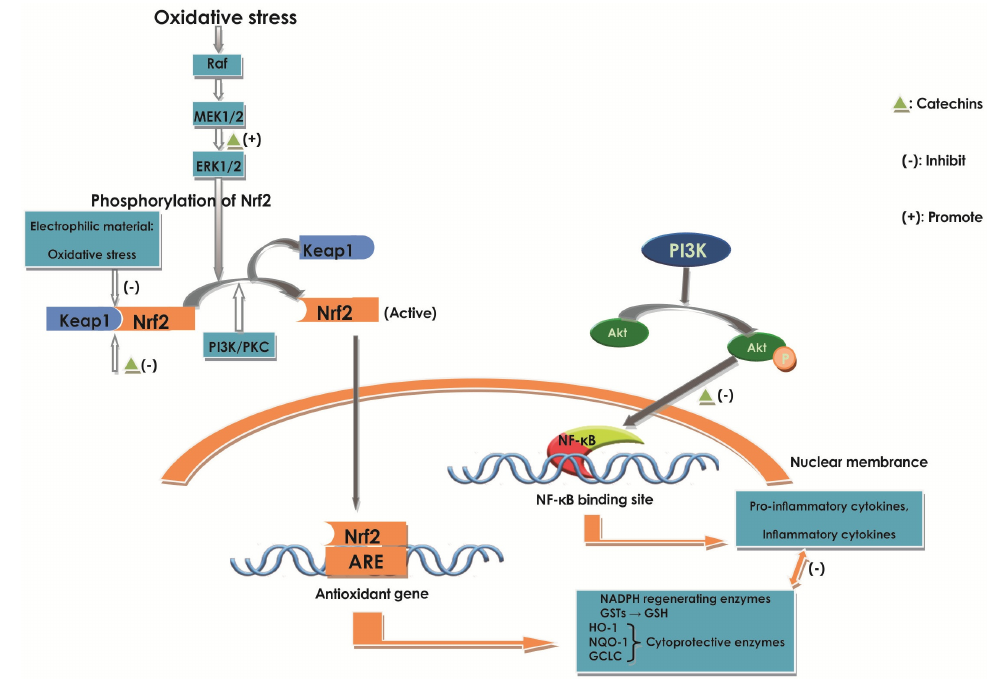
Figure 7. Catechins can activate Nrf2 by enhancing the phosphorylation of ERK1/2, then regulate the activation of Nrf2 by directly inhibiting Keap1-Nrf2 interaction or enhancing ERK1/2 expression. Catechins can regulate the Nrf2 by acting on NF- κ B.